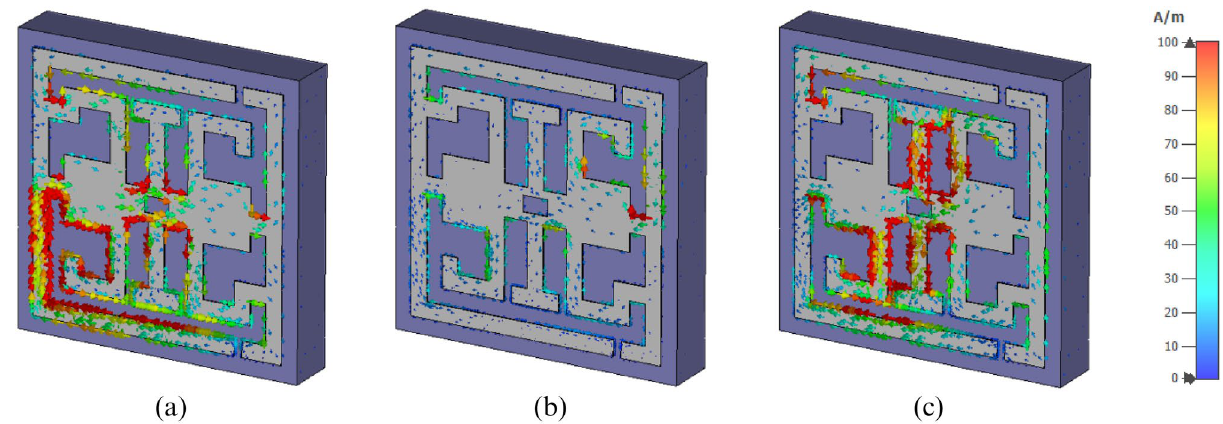
Figure 7. Surface current ( a ) 3.94 GHz, ( b ) 8.08 GHz, ( c ) 11.175 GHz (CST STUDIO SUITE 2019, https:// www. 3ds. com/ produ cts- servi ces/ simul ia/ produ cts/ cst- studio- suite) 30